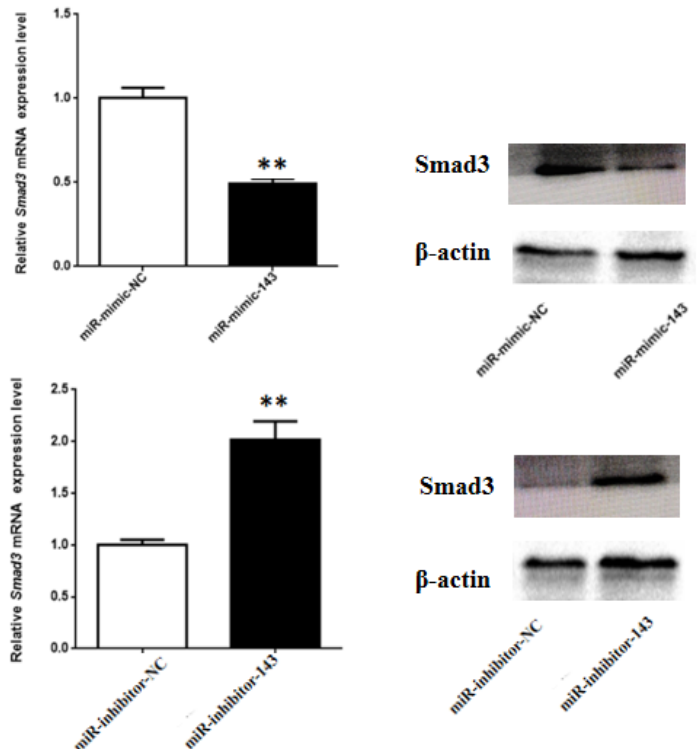
Figure 4. Impact of miR-143 on the Smad3 mRNA and protein expression. ** p < 0.01.